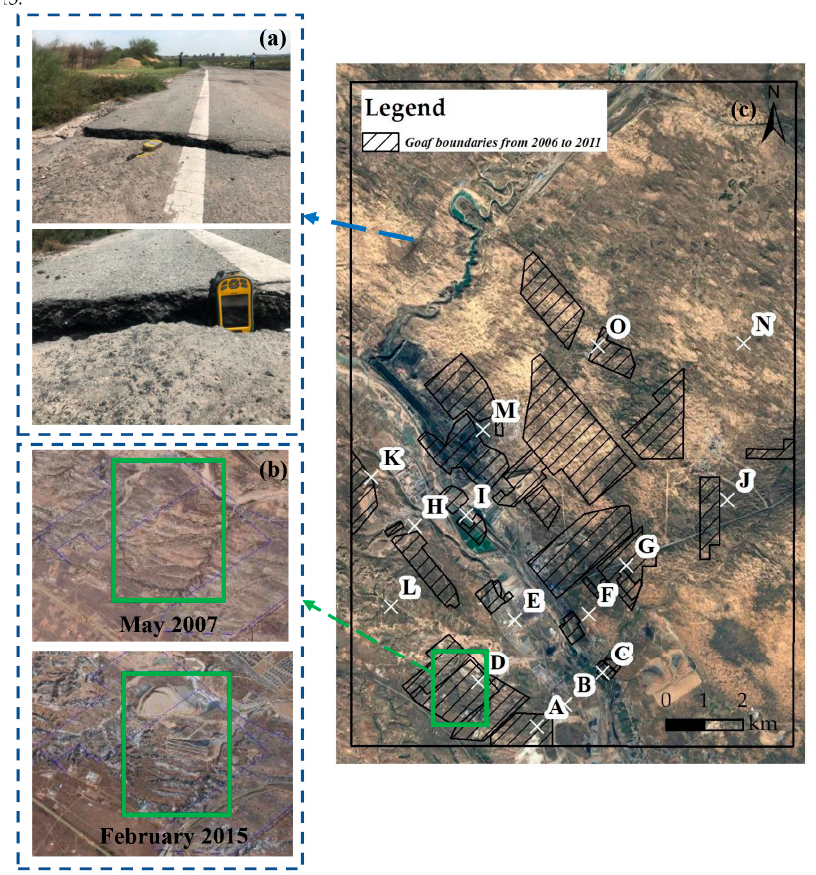
Figure 5. ( a ) Ground fissures images obtained during a field survey; ( b ) historical images of Google Figure 5. Superimpose the historical images of Google Earth in 2007 and 2015 within the boundaries Earth within the boundaries of the coal mining goafs in 2007 and 2015; ( c ) location of the coal mining of the coal mining goafs. goafs in the mining